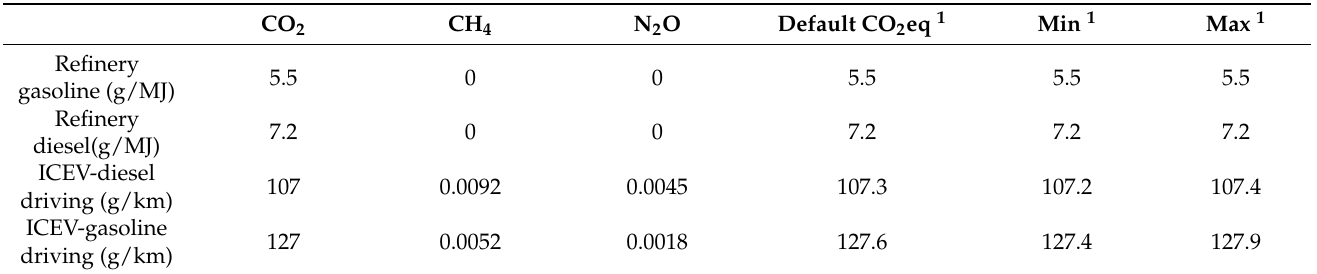
Table 4. Refining activities (attributional life cycle approach) and direct combustion in use of gaso- line/diesel [21].